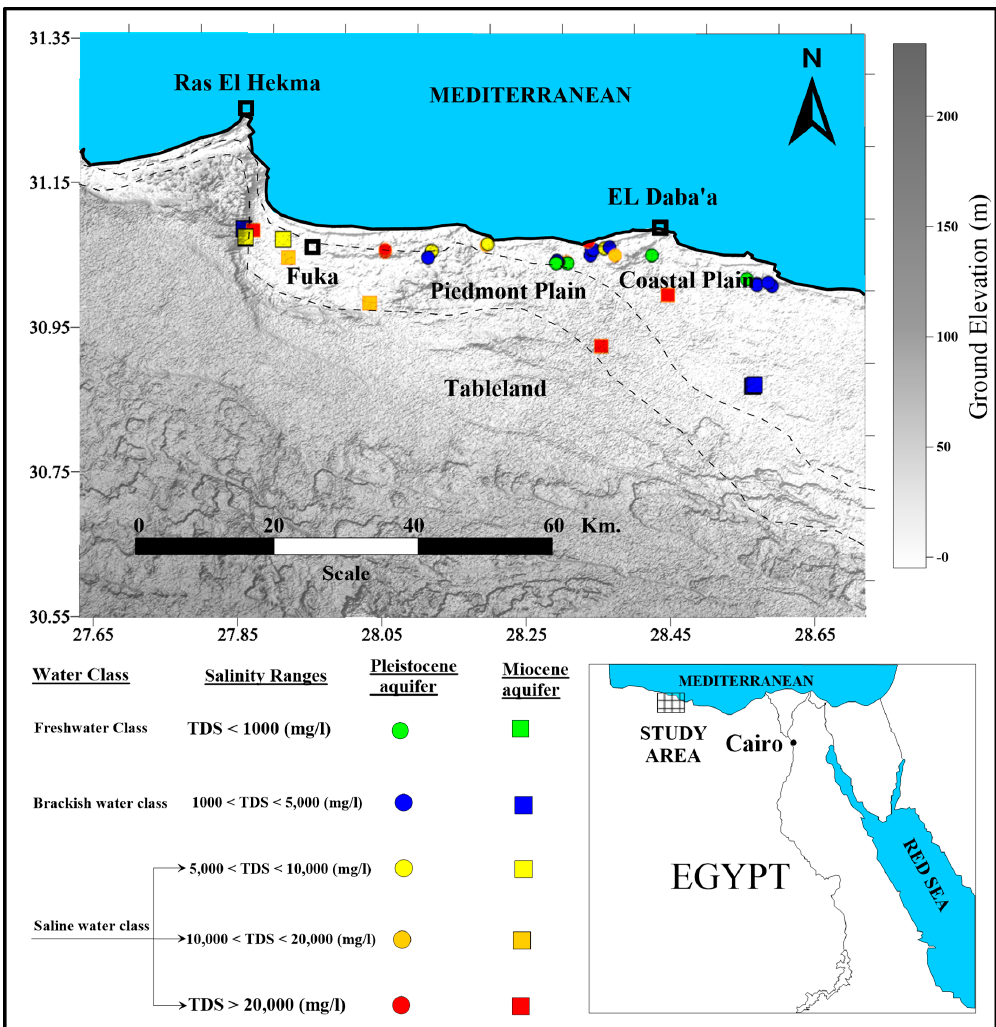
Figure 1. Location map of the study area.